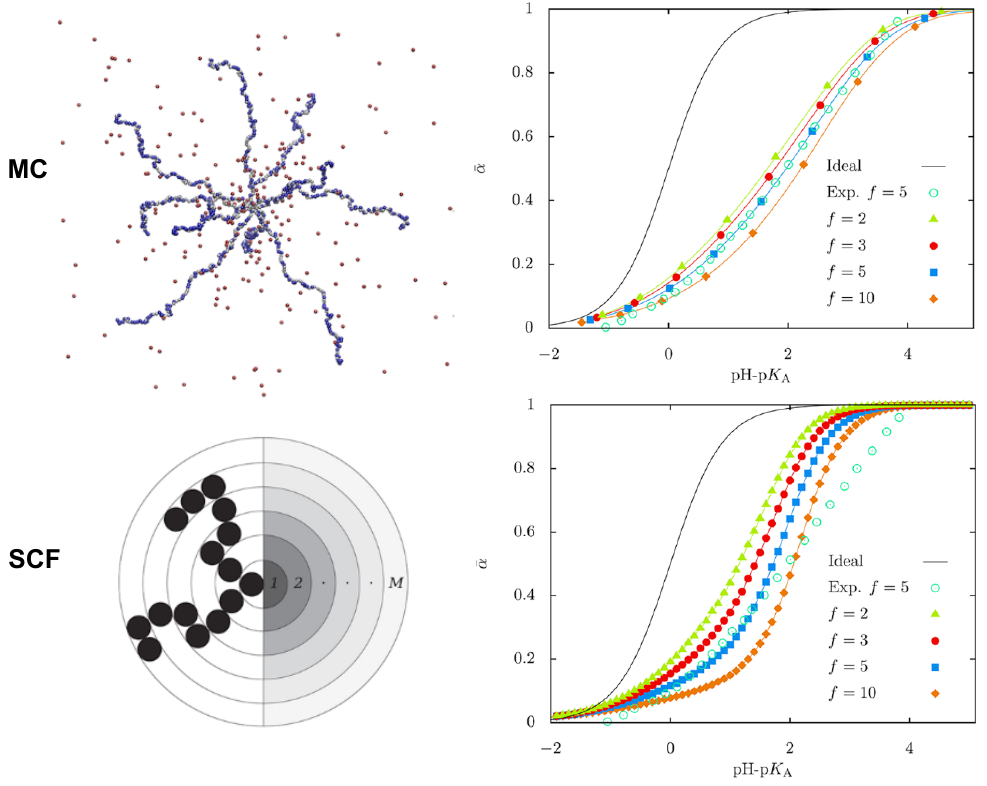
Figure 5. (Right panel) Representative MC conformation of a weak polyacid star containing 10 arms ( top left ) and illustration of the corresponding layer structure in the Scheutjens–Fleer Self-consistent (SF-SCF) model ( bottom left ). (Left panel) Average degree of dissociation as a function the difference pH- pK a , corresponding to MC simulations ( top right ) and SF-SCF calculations ( bottom right ) for stars of different number of arms ( f ), as indicated in the legend. The ideal titration curve corresponds to that of an isolated segment. (Reprinted with permission from the authors of [109]. Copyright 2014 American Chemical